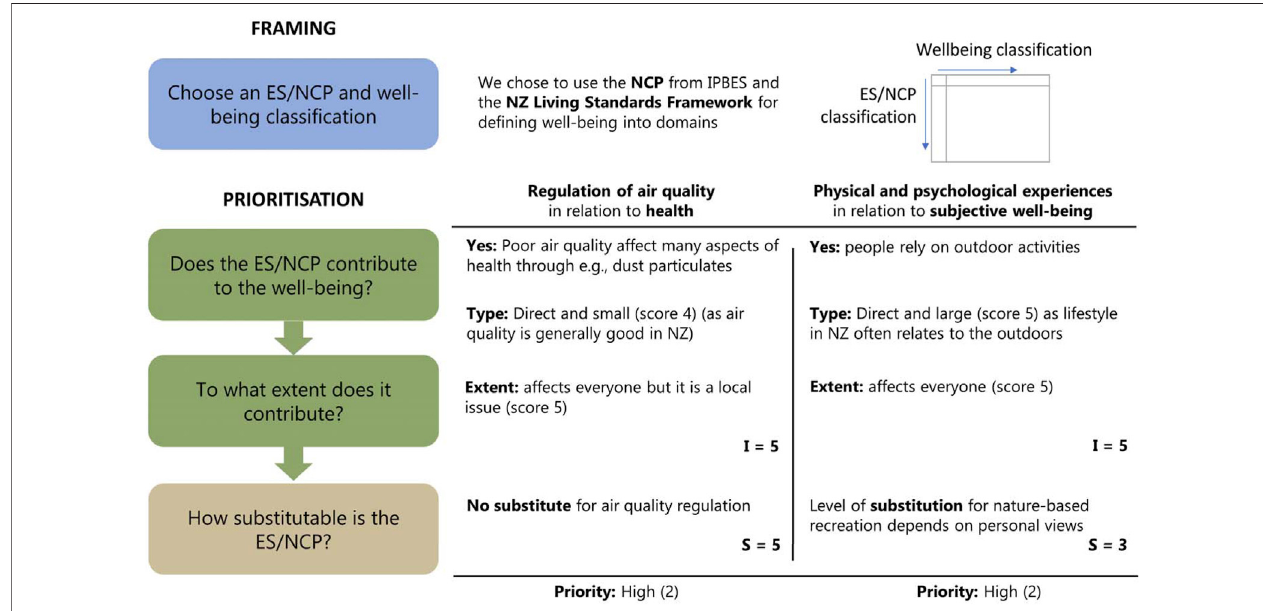
FIGURE 1 | A schematic diagram showing how the prioritization process is applied to relate ES/NCP to well-being domains.